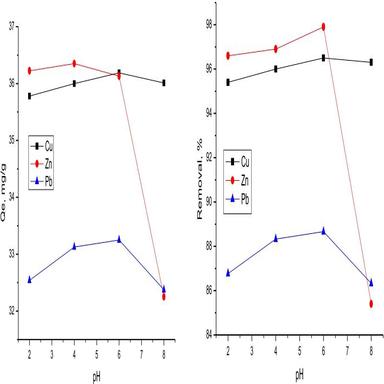
Effect of pH on removal efficiency and removal capacity of heavy metals by SiO2@C nanocomposite (SC1).